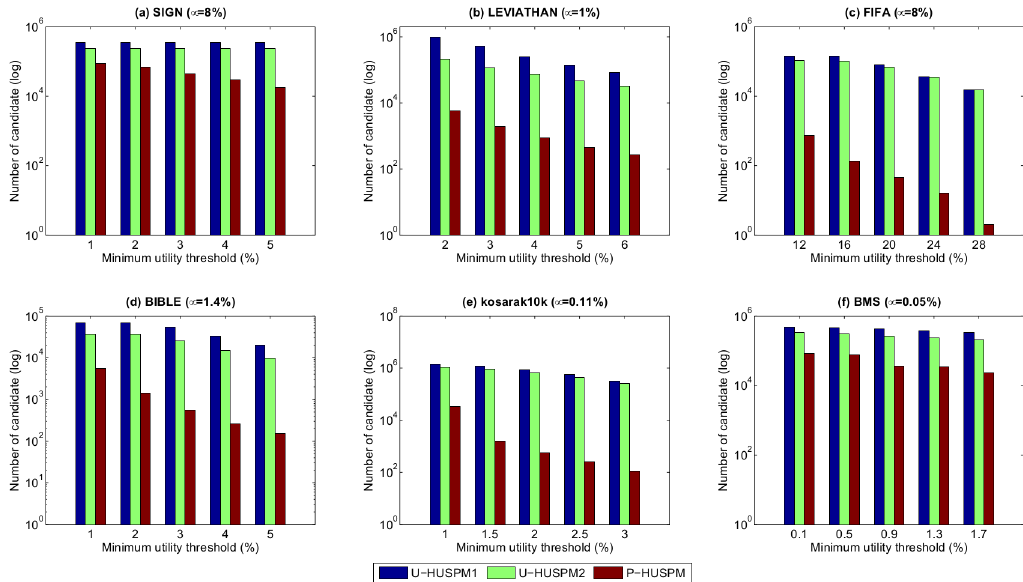
Fig 3. Number of candidates for a fixed μ when ε is varied.